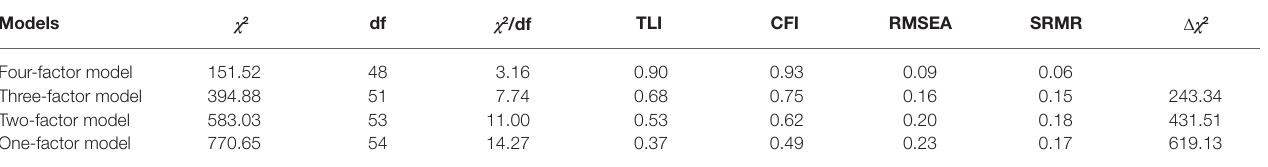
TABLE 2 | Confirmatory factory analysis